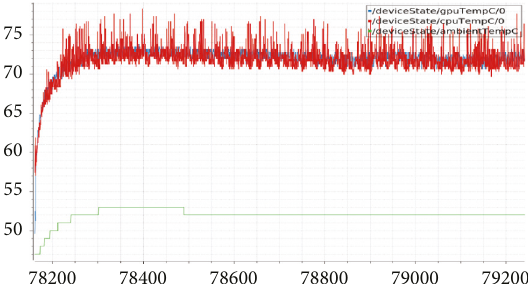
Figure 25: T1D5 temperatures.